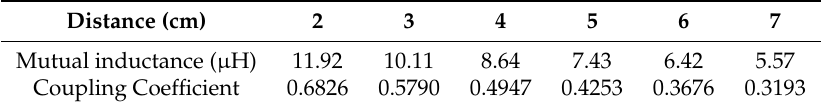
Table 3. Mutual inductance and coupling coefficient according to the distance